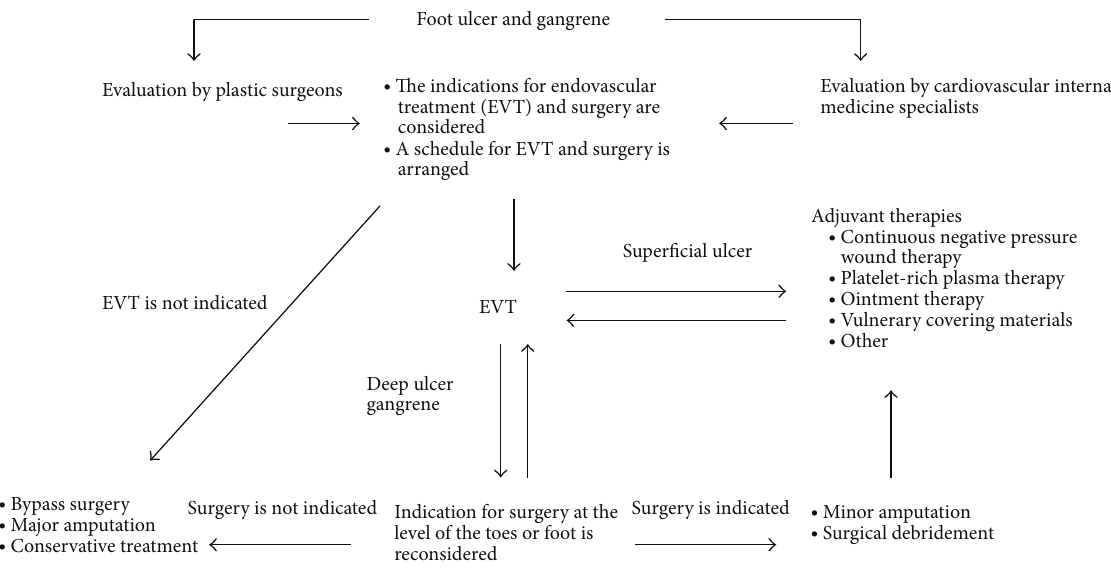
Figure 1: Treatment algorithm for critical limb